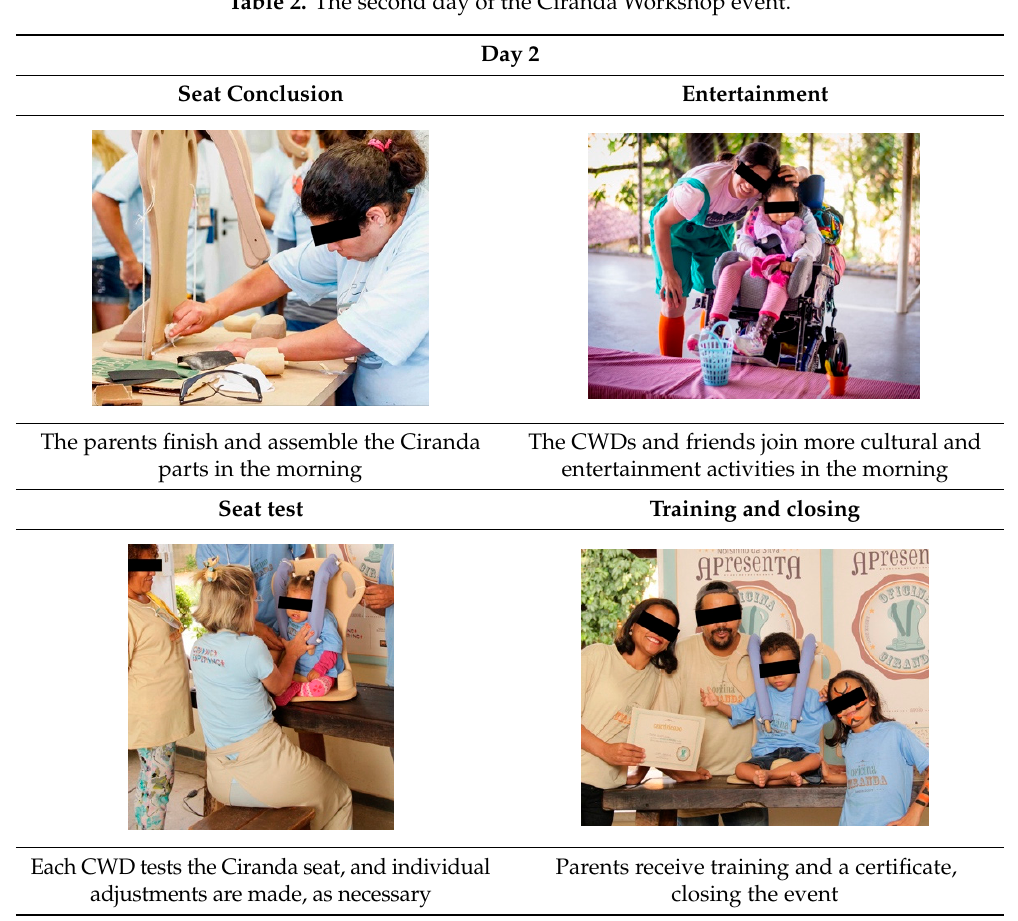
Figure 4. Concluded Ciranda seats during the second day of the Ciranda Workshop.